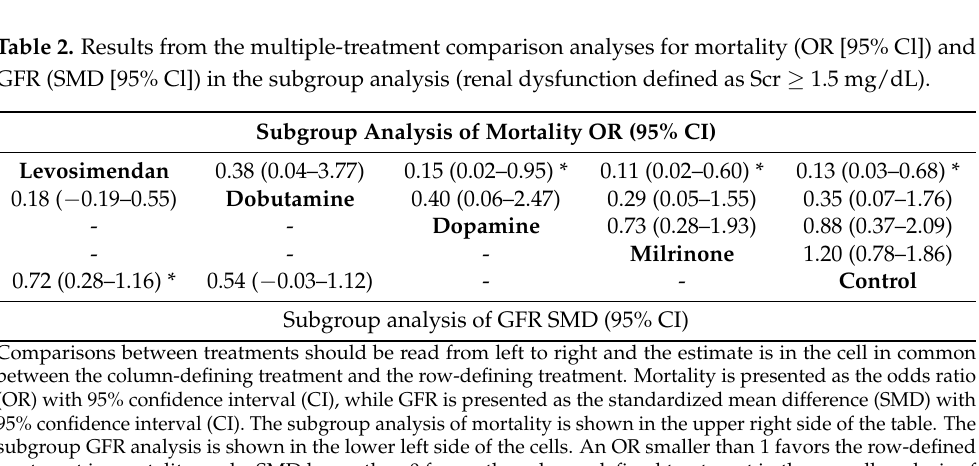
Table 2. Results from the multiple-treatment comparison analyses for mortality (OR [95% Cl]) and GFR (SMD [95% Cl]) in the subgroup analysis (renal dysfunction defined as Scr ≥ 1.5 mg/dL). Subgroup Analysis of Mortality OR (95% CI) Levosimendan